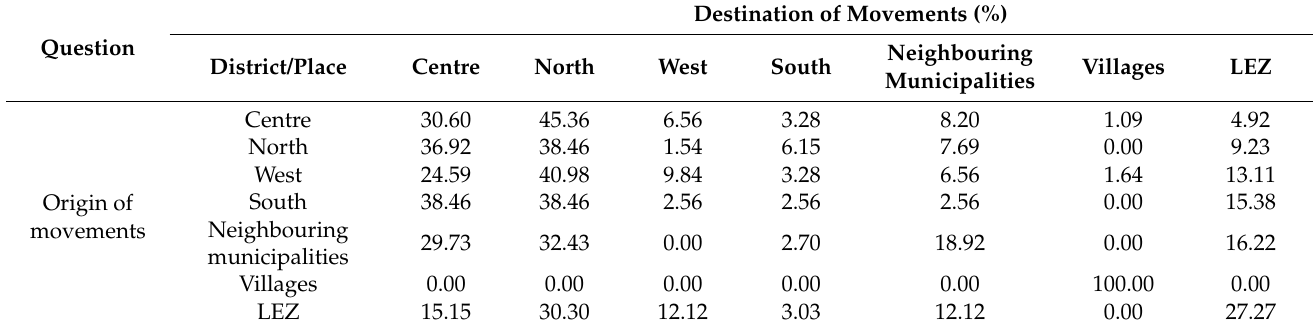
Table 2. Origin-destination of